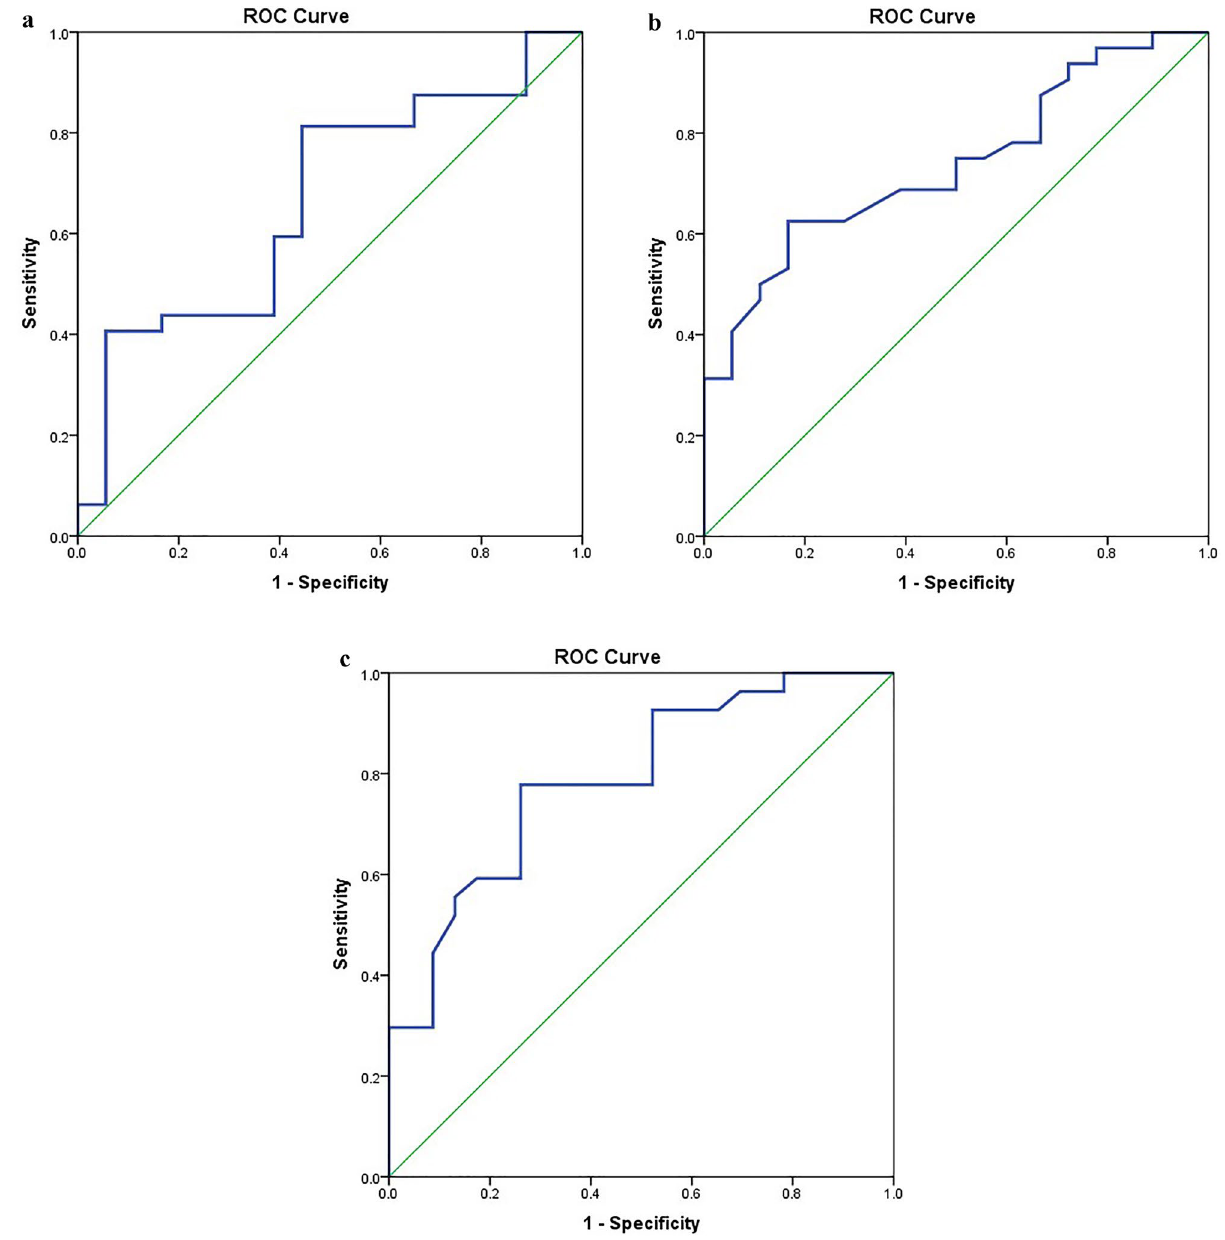
Figure 4. ( a ) ROC curve analysis for the accuracy of the association between serum level of IL-10 and lymphopenia in COVID-19 patients. SPSS software version 22 was used. IL-10 increased in patients with lymphopenia compared to patients with normal lymphocytic count with good discriminating efficiency with AUC = (0.66±0.08 p = 0.05*). SPSS software version 22 was used. ( b ) ROC curve analysis for the accuracy of the association between serum level of TLR-4 and lymphopenia in COVID-19 patients. TLR-4 increased in patients with lymphopenia compared to patients with normal lymphocytic count with good discriminating efficiency with AUC = (0.73±0.07 p = 0.006*). SPSS software version 22 was used. ( c ) ROC curve analysis for the accuracy of the association between serum level of TLR-4 in COVID-19 patients and chest CT severity score (CSS). Serum level of TLR-4 increased in patients with CSS >19 compared to patients with CSS >19 with good discriminating efficiency with AUC = (0.78±0.06 p = 0.0001*). SPSS software version 22 was